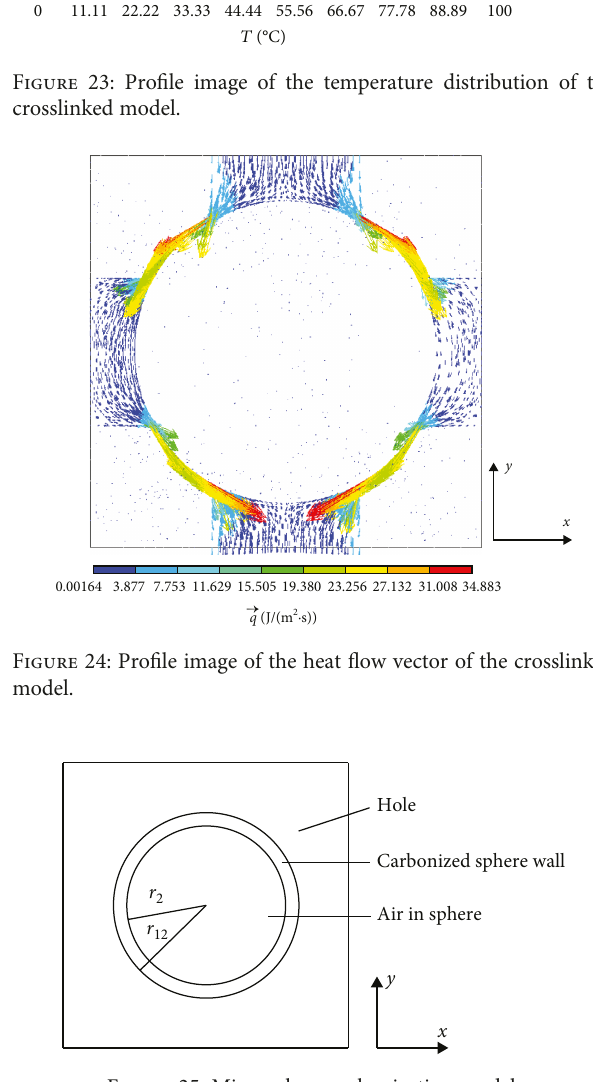
Figure 22: Heat fl ow vector of the crosslinked model.